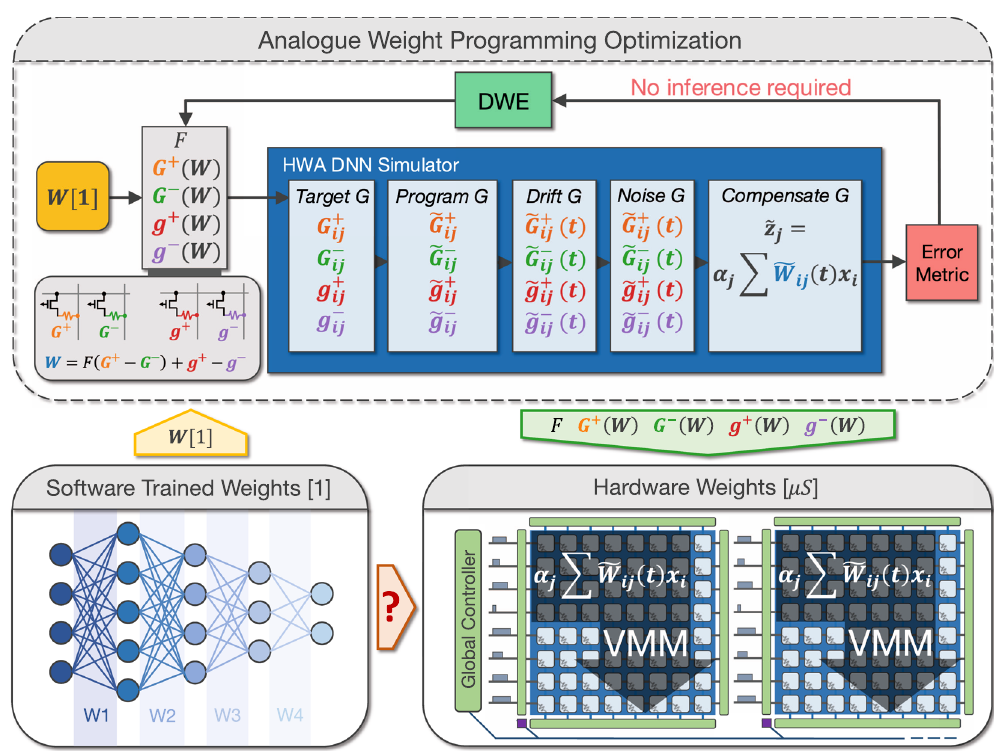
Fig. 1 Overview of the weight programming optimisation framework. ‘ Unitless ’ weights from software DNN models must be re-scaled into an optimal hardware range (microSiemens), and can be encoded across multiple analogue memory devices: G + , G − , g + , and g − with varying signi fi cance de fi ned by F . A weight programming optimisation framework captures all memory imperfections and hardware compensatory techniques, and produces optimal weight programming strategies using an iterative Differential Weight Evolution (DWE) technique to minimise inference accuracy degradations for analogue memory-based DNNs, including degradations that change over time. This can be achieved without the need to run costly inference simulations at multiple time-steps using large